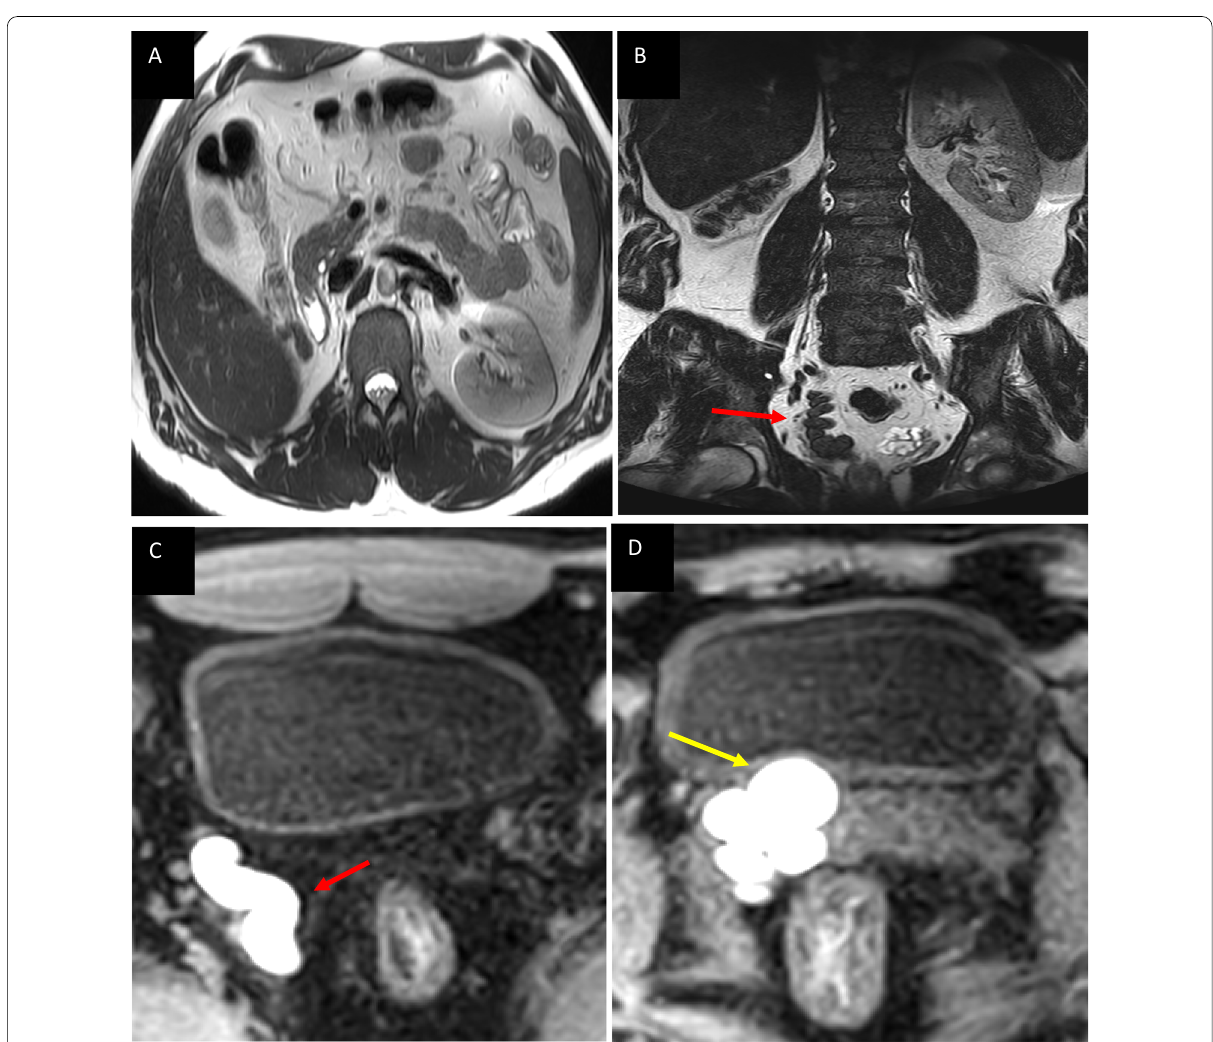
Fig. 2 A Axial T2WI of the abdomen and B coronal T2WI of the abdomen and pelvis show normal left renal unit and right renal agenesis and tubular cystic structure at the right side of the pelvis displays low T2WSI (red arrow), C – F high‑resolution axial fat‑suppressed T1WI and axial T2WI of the pelvis revealed normal left SV (blue arrow) and dilated right one with cyst (yellow arrow) measured (2 posterolateral vesical wall anteriorly; both of the cyst and the tubular structure display high T1WSI and low T2WSI denoting hemorrhagic or high proteinaceous content (red arrow), G and H high‑resolution coronal T2WI of the pelvis show the right SV cyst as well as presence of right sided pelvic cystic tubular structure (red arrow) seen connected with the dilated right SV which resembles right rudimentary ureteric bud with abnormal insertion into right SV, I and J high‑resolution right parasagittal T2WI of the pelvis confirm the same